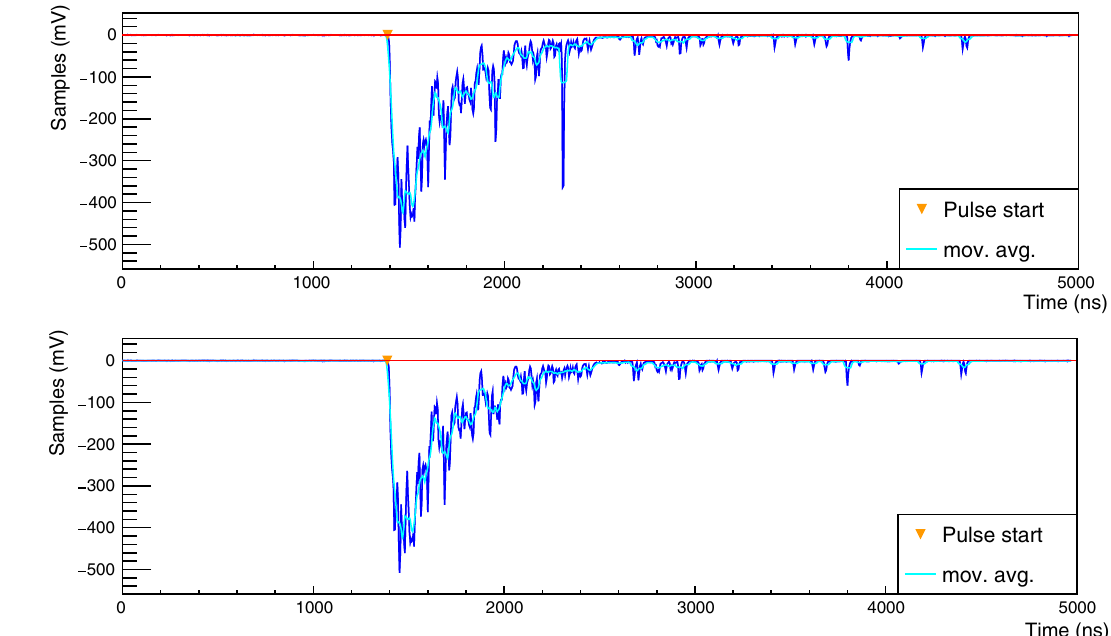
Fig. 2 Example of AP suppression. (Top) original signal acquired with the NaI-33 crystal affected by the presence of an AP, clearly visible as an anomalous spike several hundred of ns after the beginning of the main scintillation pulse. (Bottom) AP suppressed waveform